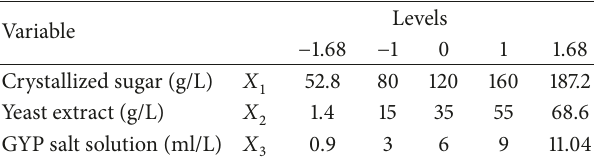
Table 1: Variables and respective levels for D( − ) lactic acid produc- tion using response surface